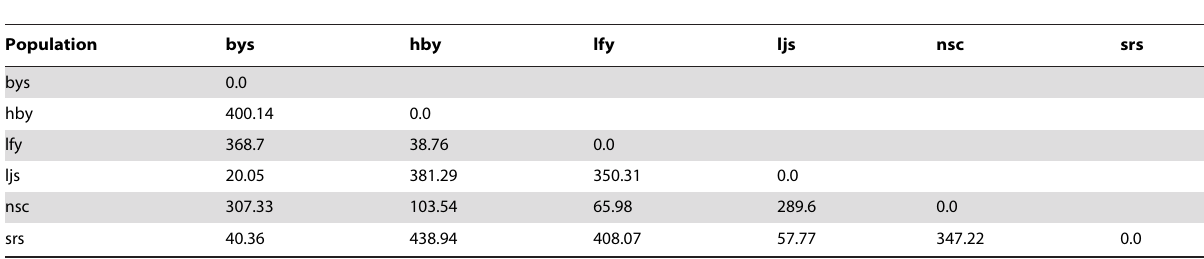
Table 5. Geographical distances among populations.